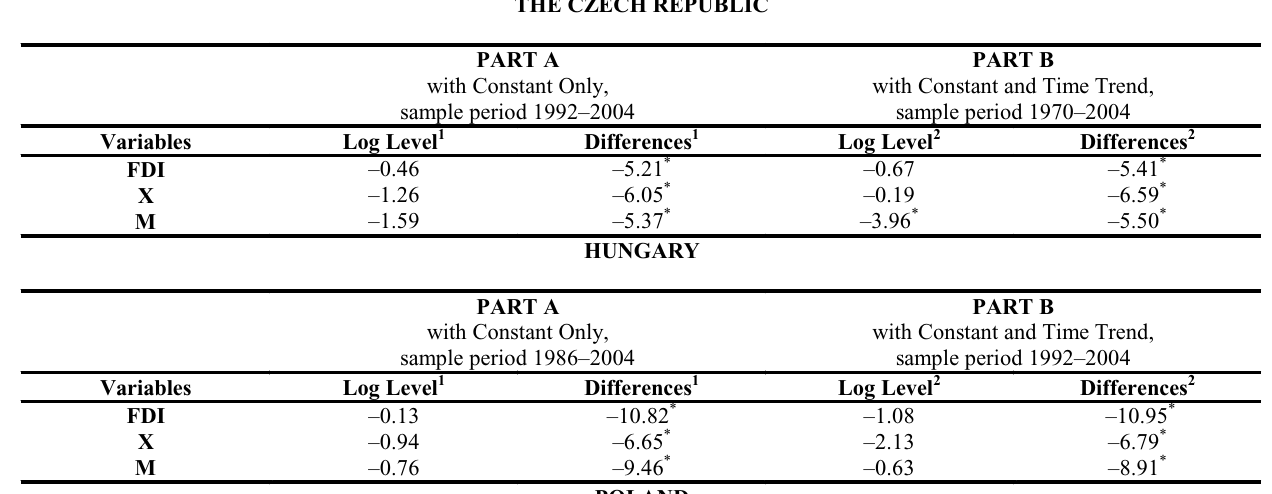
Table 11. Unit root tests for